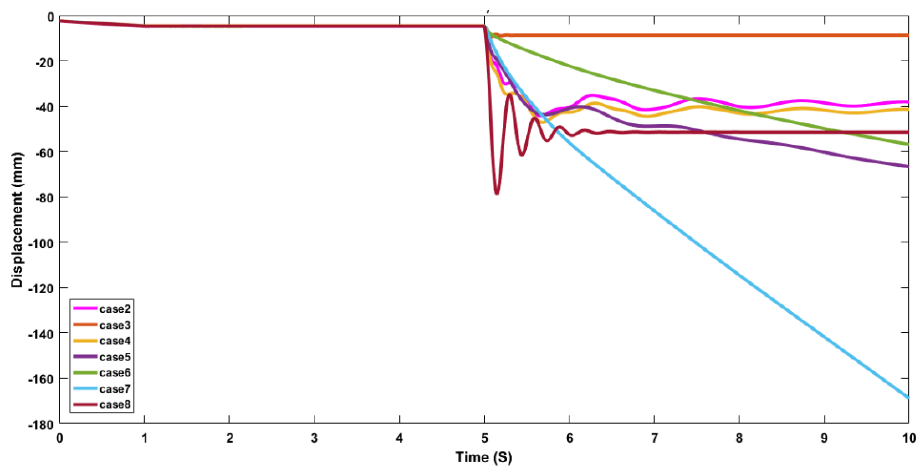
Figure 16. Vertical displacement at column removed position due to column loss in story six.